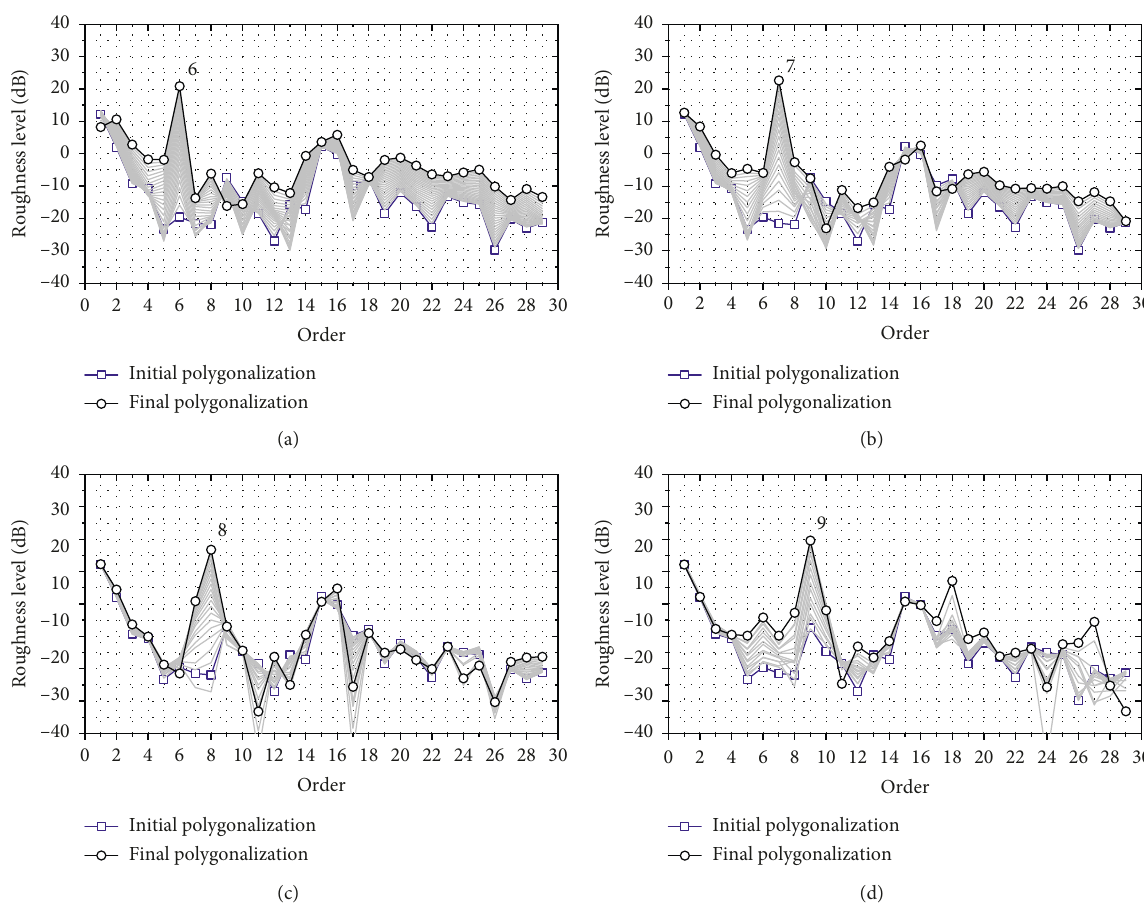
Figure 22: Evolution of wheel polygonalization at different rail pad stiffness values: (a) 35 MN/m after 27,500km; (b) 55MN/m after 22,000km; (c) 75MN/m after 11,000km; (d) 110MN/m after